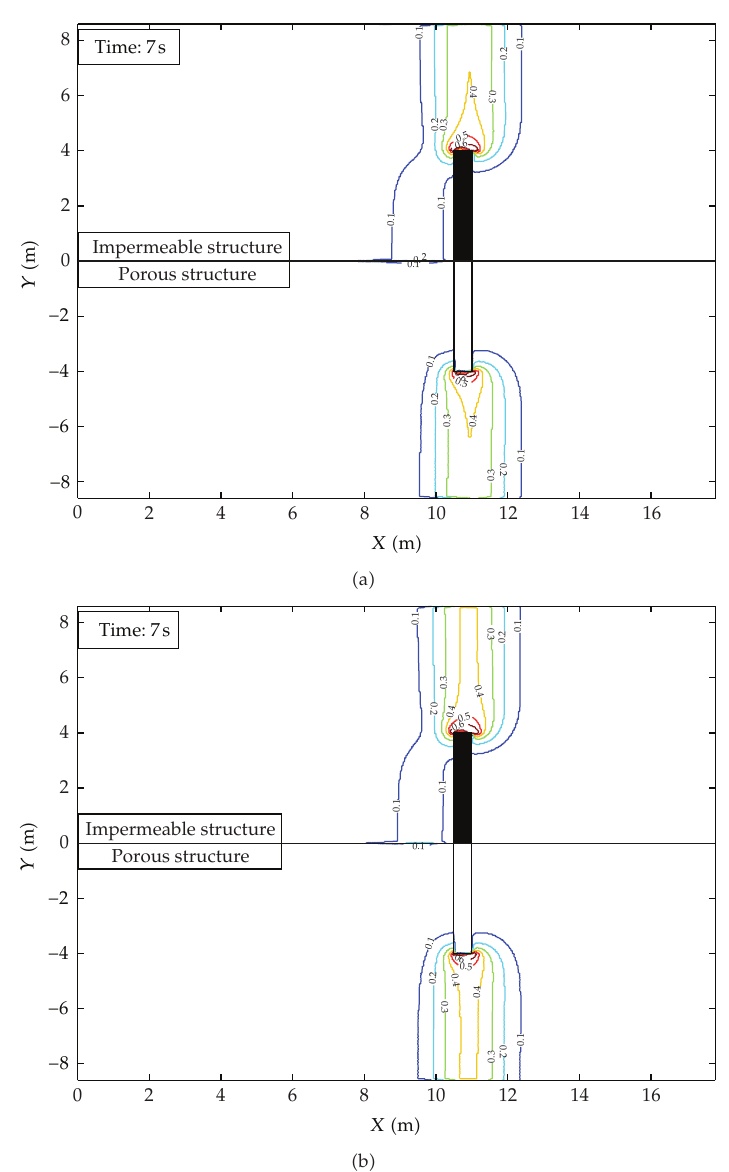
Figure 8: Velocity module isolines for the impermeable and porous structure under the action of the solitary wave case of height H (cid:7) 9cm and water depth h (cid:7) 40cm. Data in m / s. Upper figure slice at plane z (cid:7) 0 . 02m. Lower figure slice at plane z (cid:7) 0 . 2m, part I. the model to evaluate wave flow within the porous media by means of the volume-averaged Reynolds-averaged Navier-Stokes equations (cid:2) VARANS (cid:3) is used here, to describe di ff erent tsunami wave transformation processes in the near field. The model, previously validated by (cid:5) 8, 9 (cid:6) , has been described in detail, paying special attention to the numerical scheme used in both time and spatial